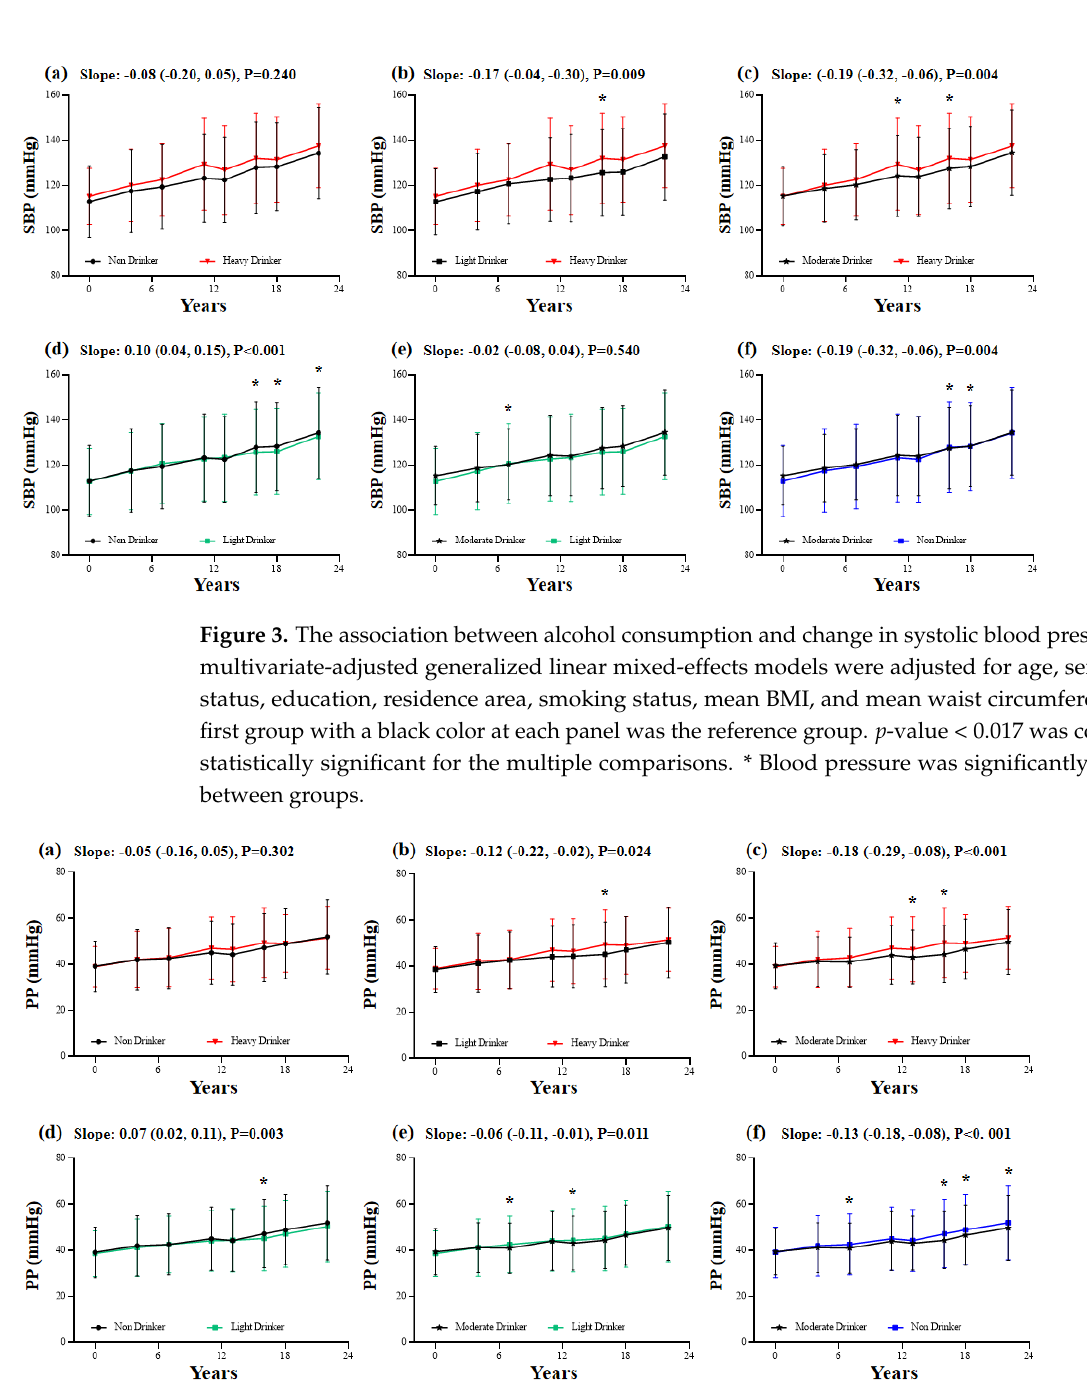
Figure 4. The association between alcohol consumption and change in pulse pressure. The multi- variate-adjusted generalized linear mixed-effects models were adjusted for age, sex, marital status, education, residence area, smoking status, mean BMI, and mean waist circumference. The first group with a black color at each panel was the reference group. p -value < 0.017 was considered statistically significant for the multiple comparisons. * Blood pressure was significantly different between groups.